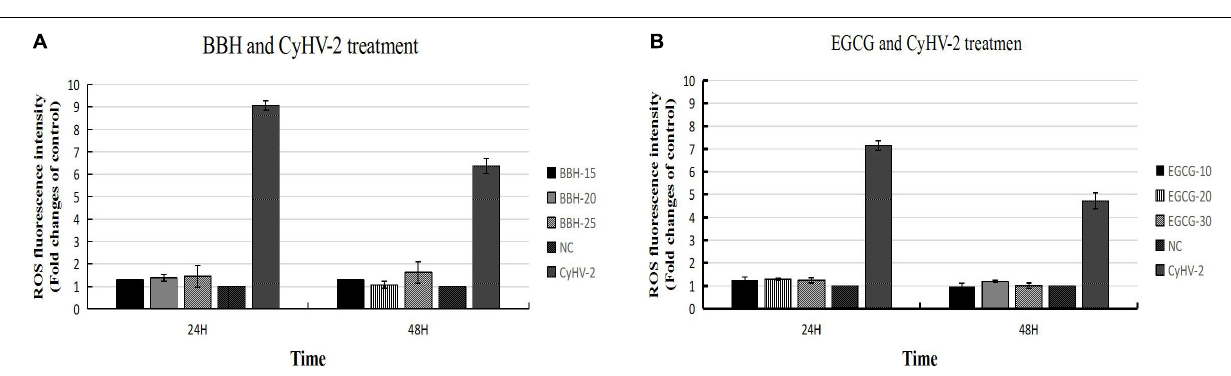
FIGURE 6 | BBH and EGCG antagonized the ROS induction mediated by CyHV-2 infection in RyuF-2 cells. RyuF-2 cells were treated with 15, 20, and 25 µ g/ml BBH (A) or 10, 20, and 30 µ g/ml EGCG (B) and infected with CyHV-2 at a MOI = 1. At 24 and 48 h p.i., cells were harvested for ROS detection as reflected by the strength of fluorescence signal. MOCK-infected cells served as the negative control and CyhV-2-infected cells without BBH or EGCG treatment served as positive control. Similar results were obtained from three independent experiments. Data were represented as means